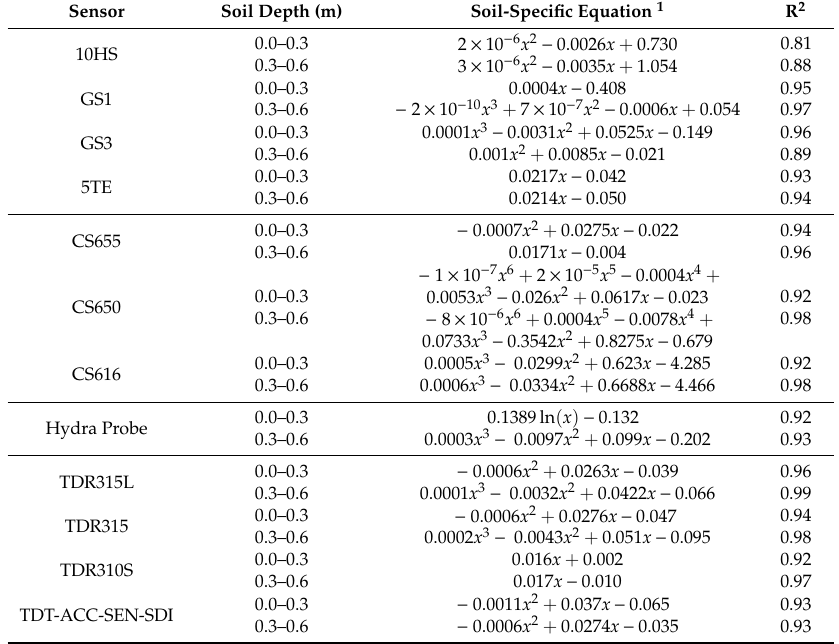
1 Variable corresponds to the response value of the sensor (voltage, period, or dielectric constant). The obtained result from each equation is the soil volumetric water content ( θ v ). Measuring technique: Frequency Domain Reflectometry—FDR (10HS, GS1, GS3, and 5TE); Transmission Line Oscillation—TLO (CS655, CS650, and CS616); Time Domain Reflectometry—TDR (Hydra Probe, TDR − 315L, TDR − 315, and TDR − 310S); and Time Domain Transmissometry—TDT (TDT-ACC-SEN-SDI). Table 7. Soil-specific calibration equations for commercial soil moisture sensors in the Astatula soil series.